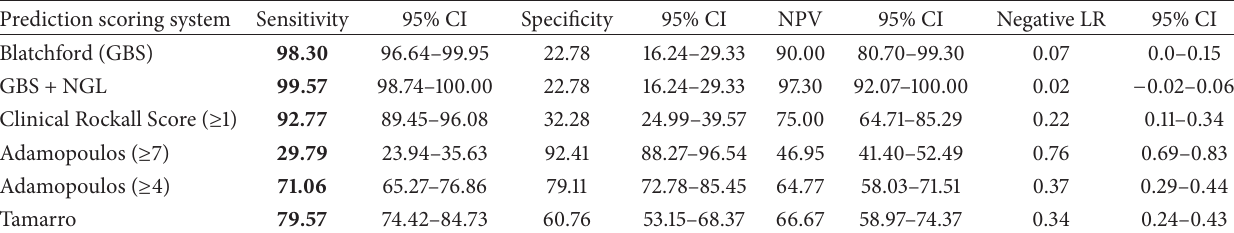
Table 4: Test parameters for each scoring